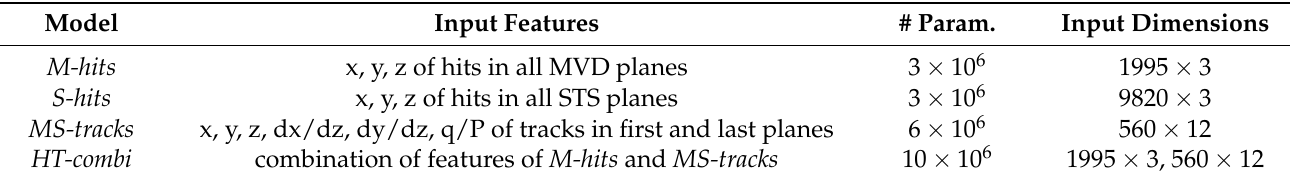
Table 1. Properties of the PointNet models developed in the study. The number of parameters (# param.) refers to the total number of parameters of the Neural Network. The first dimension of the input is defined by the maximum number of tracks or hits expected in an event while the second dimension is the number of input features considered for each point in the pointcloud. e.g., The M-hits is expected to have up to 1995 hits where 3 features (x, y, z) of each hit is used for